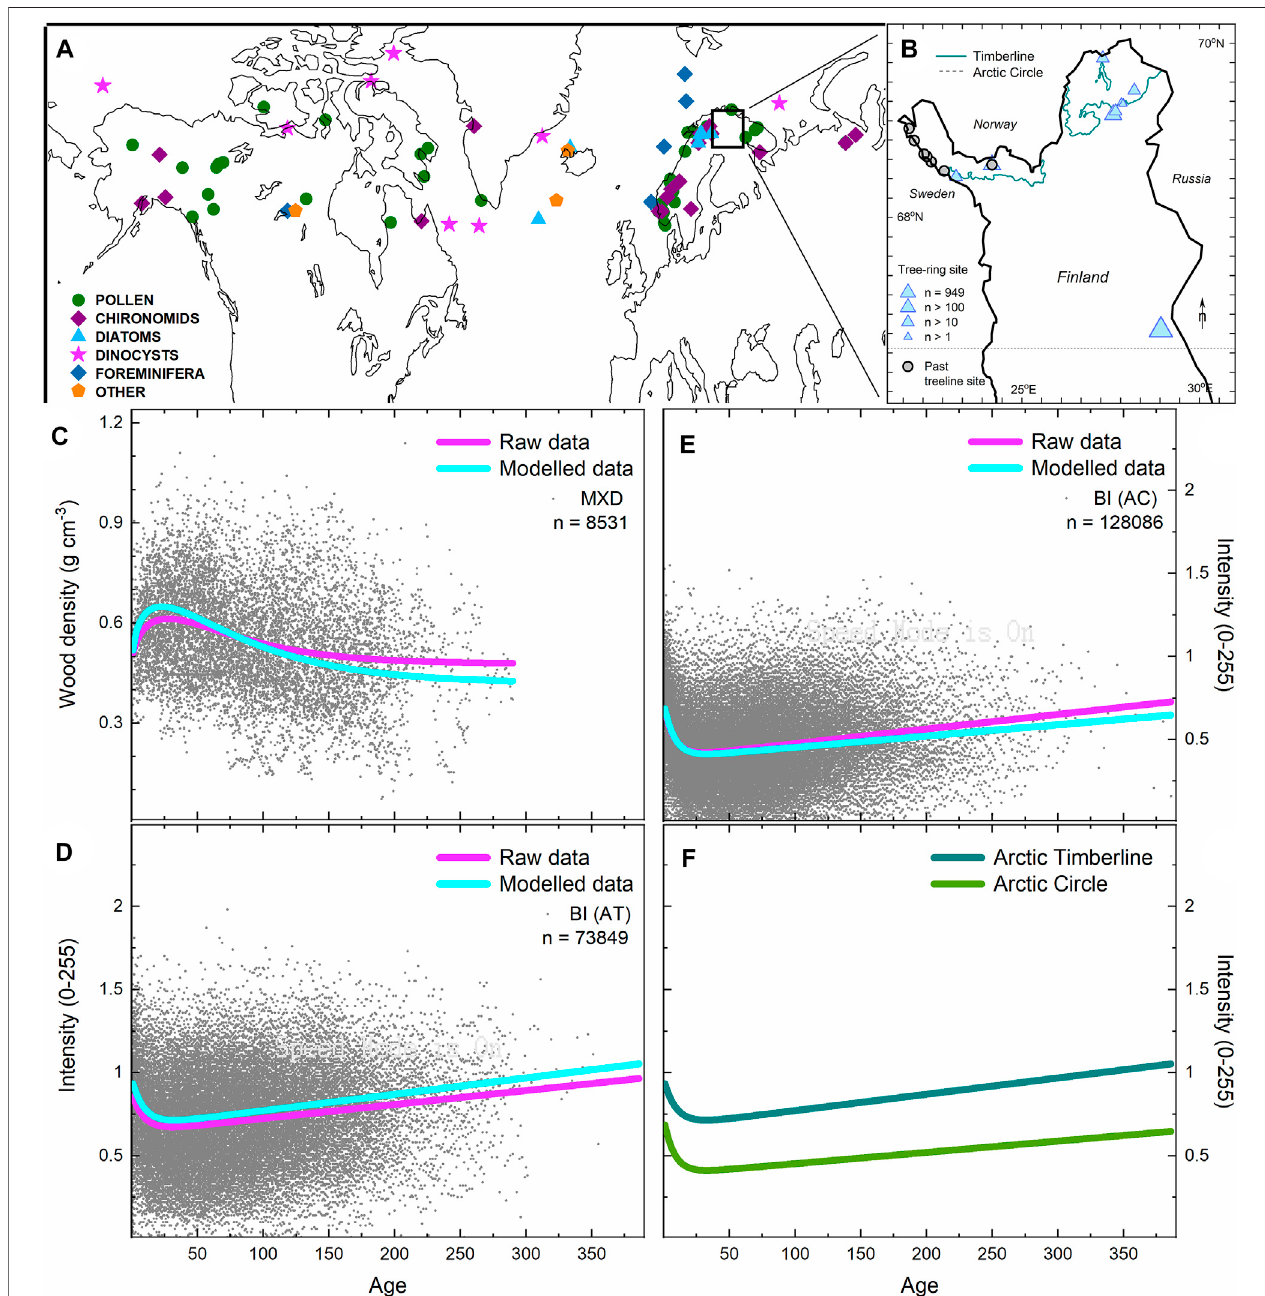
FIGURE1| Datacharacterization. (A) Tree-ringandotherproxysitesaroundtheArcticregionand (B) inFinnishLapland.Tree-ringsitesrepresentnewdataofthis study. Multiproxy data represent previously archived (Sundqvist et al., 2014) temperature records. Past tree-line sites represent published (Seppä et al., 2002; Helama et al., 2004a) and new data. Tree-ring data from Pinus sylvestris trees show age-related trends in (C) maximum latewood density (MXD) and minimumblue channel light intensity (BI) from the trees at (D) Arctic Timberline (AC) and (E) Arctic Circle (AC). Growth trends were determined for raw and modeled (Melvin and Briffa, 2008) tree-ring data. (F) BI data from the Arctic Timberline exhibit higher BI values than from the Arctic Circle.